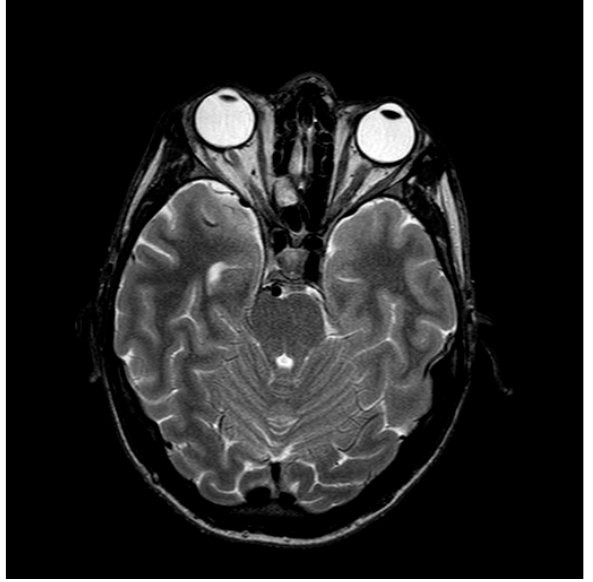
Figure 5. Magnetic resonance imaging of the head, showing no pathological changes intracranially or in the course of the optic nerves.